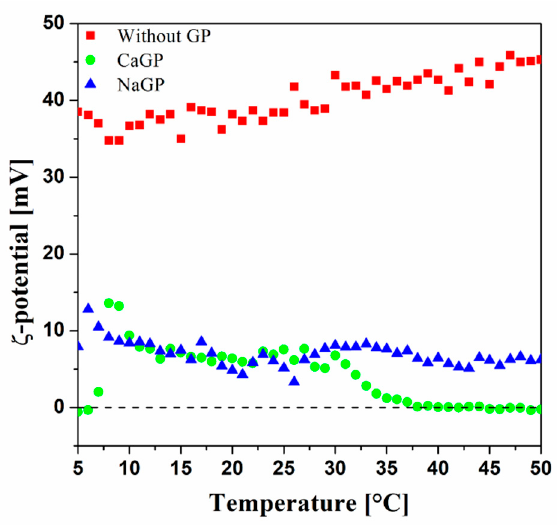
Figure 1. Experimental curves of Zeta potential for samples without glycerophosphate,